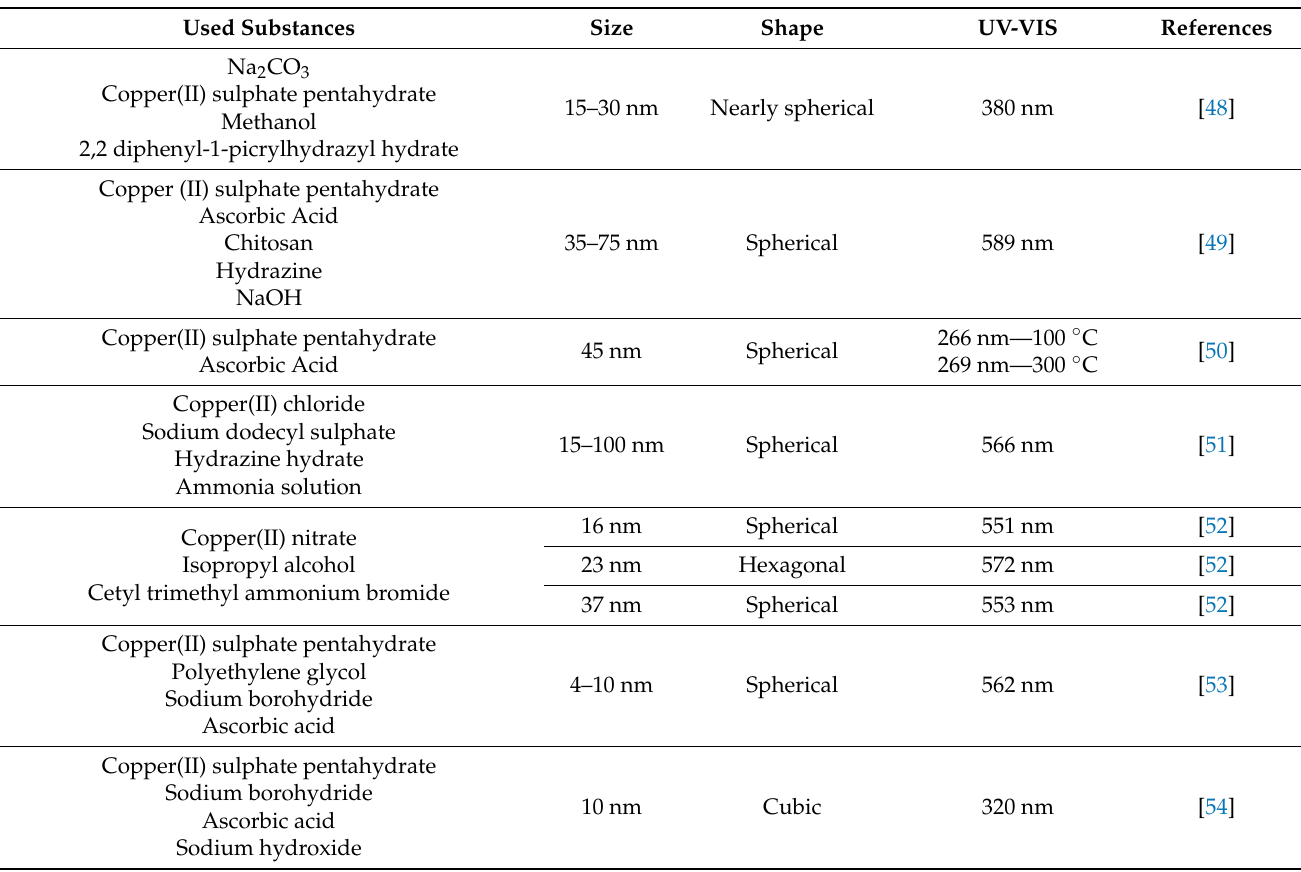
Table 4. Chemical synthesis methods of copper